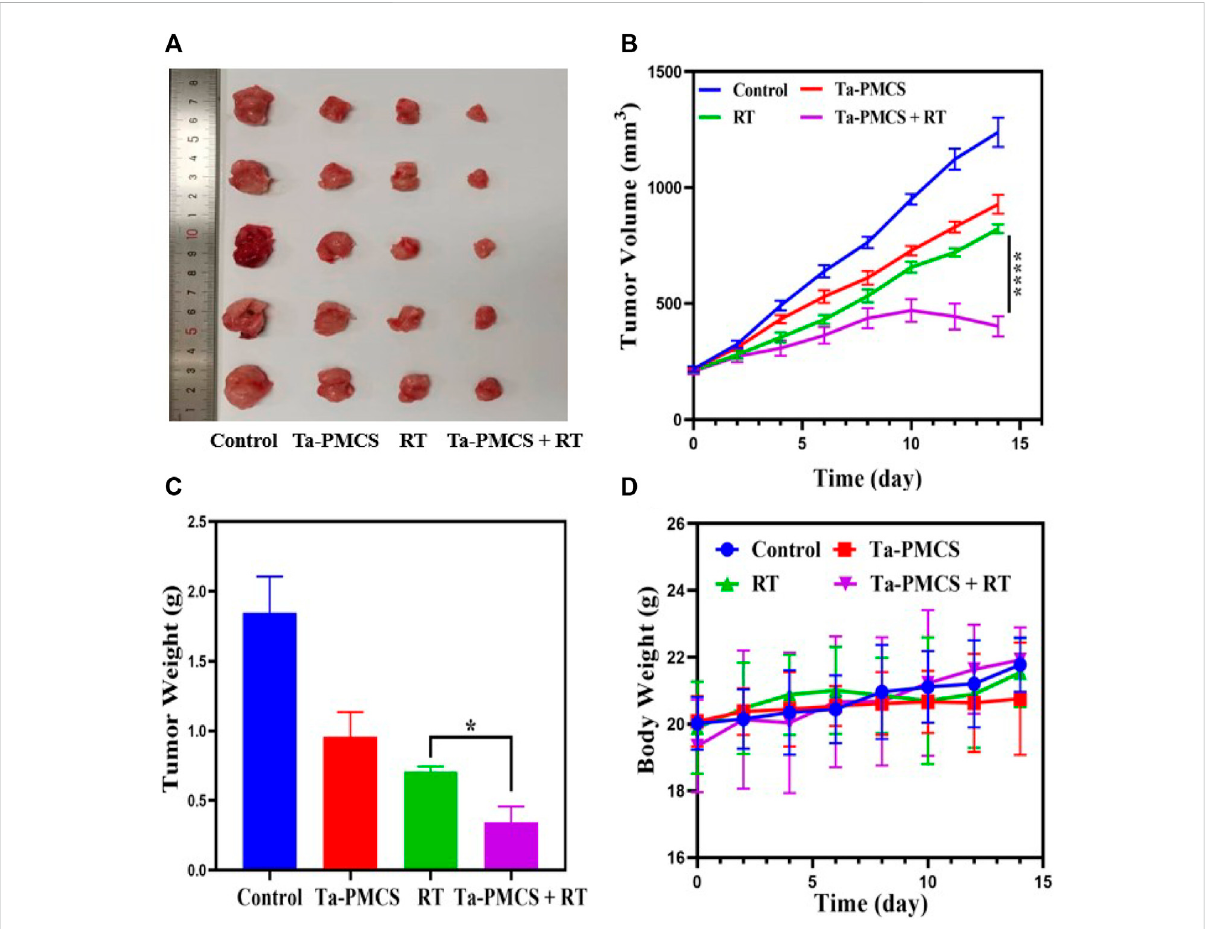
Tumor growth inhibition after treated with the control, Ta-PMCS, RT or Ta-PMCS + RT in vivo . (A) The gross tumor appearance after treat with different treatments; (B) tumor volume changes in different groups; (C) tumor weight; (D) body weight changes. * p < 0.05, ** p < 0.01, *** p <